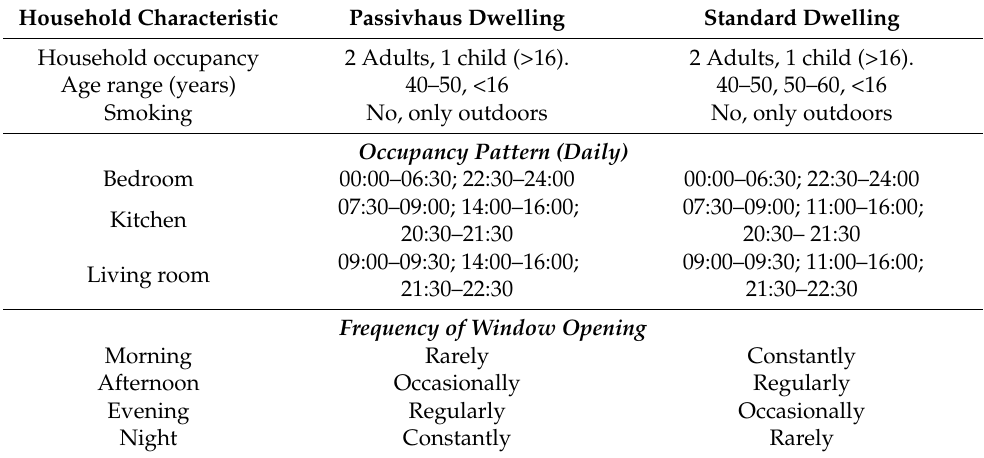
Table 1. Household characteristics. Source: Authors.